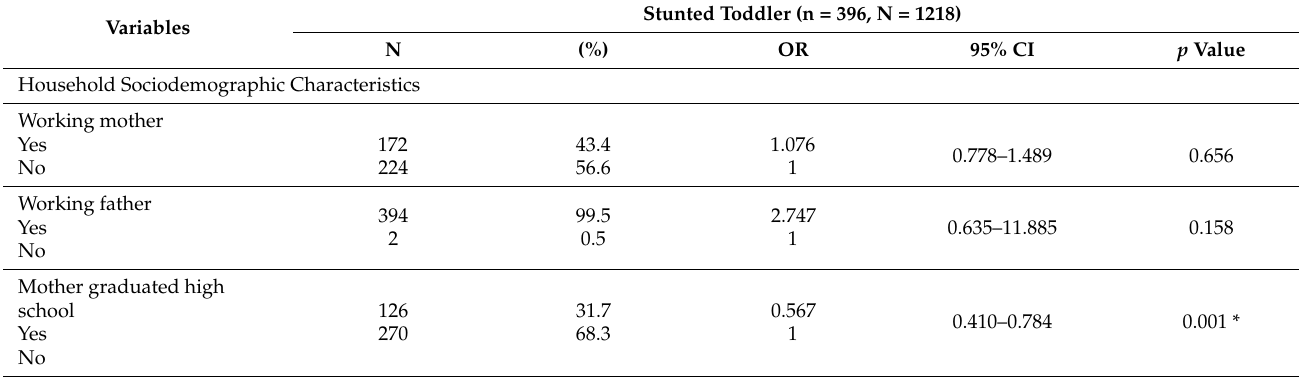
Table 1. Bivariate Analysis between Independent Variables and Stunting